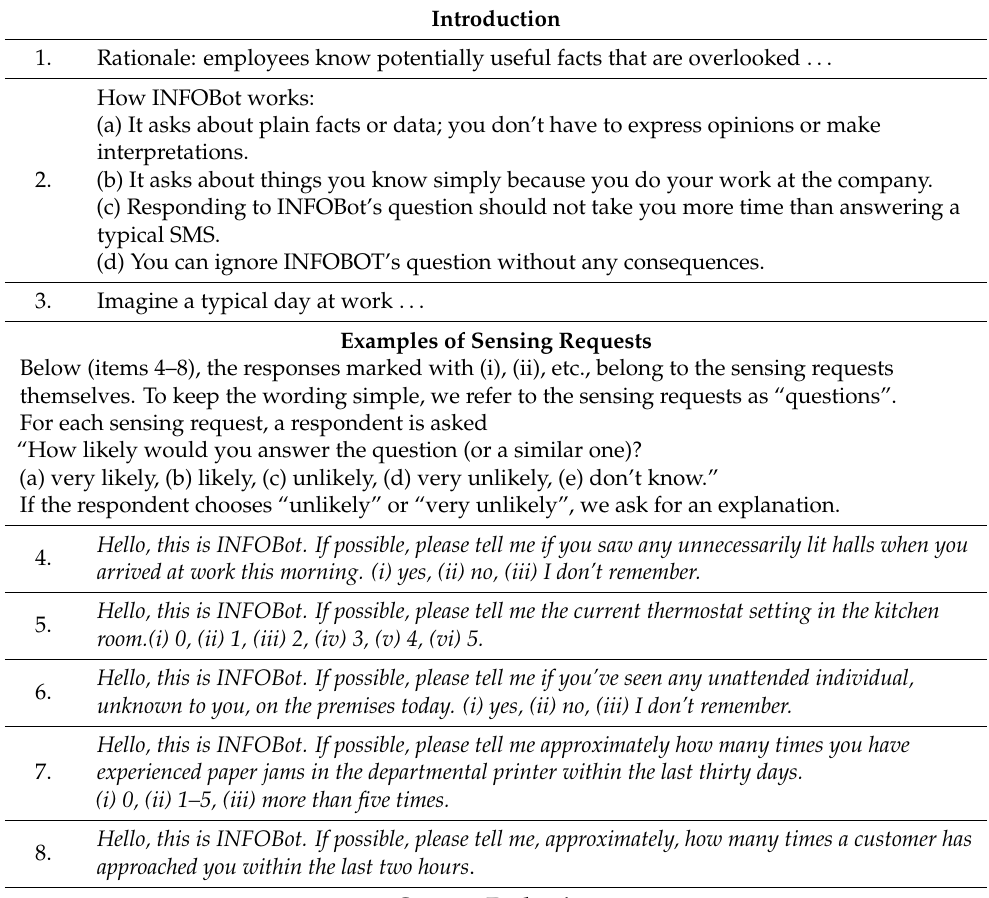
Table 2. The ICC evaluation